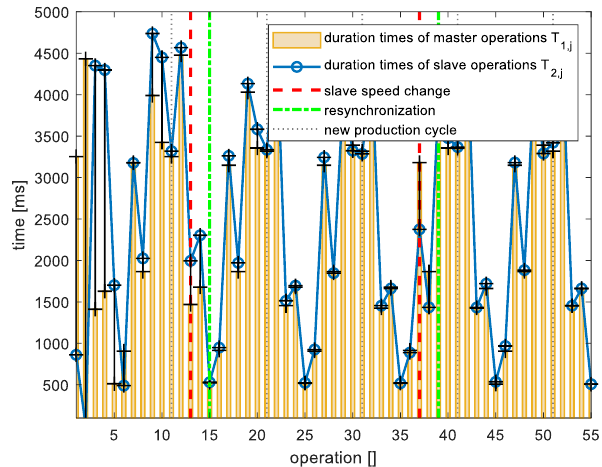
Figure 13. Operation duration times of master and slave manipulators with feedforward synchronization — Experiment 2b.